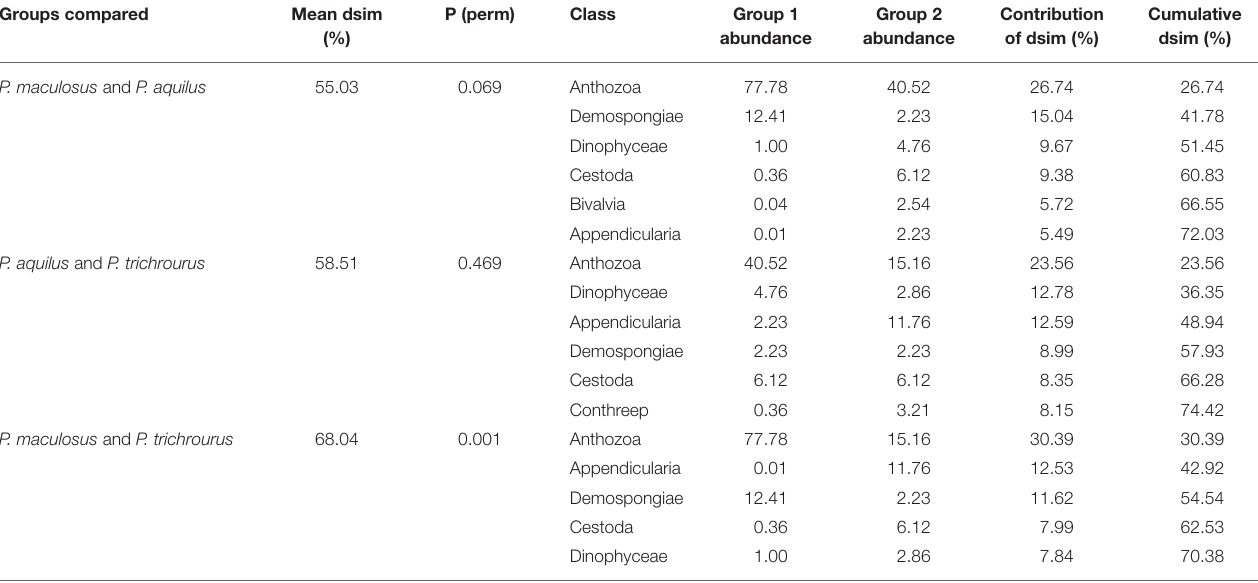
TABLE 2 | Results of SIMPER and PERMANOVA analyses of dissimilarity (dsim) between pairs of groups of species, showing the top contributors to the total dissimilarity in each group (cut off 70%). Groups compared